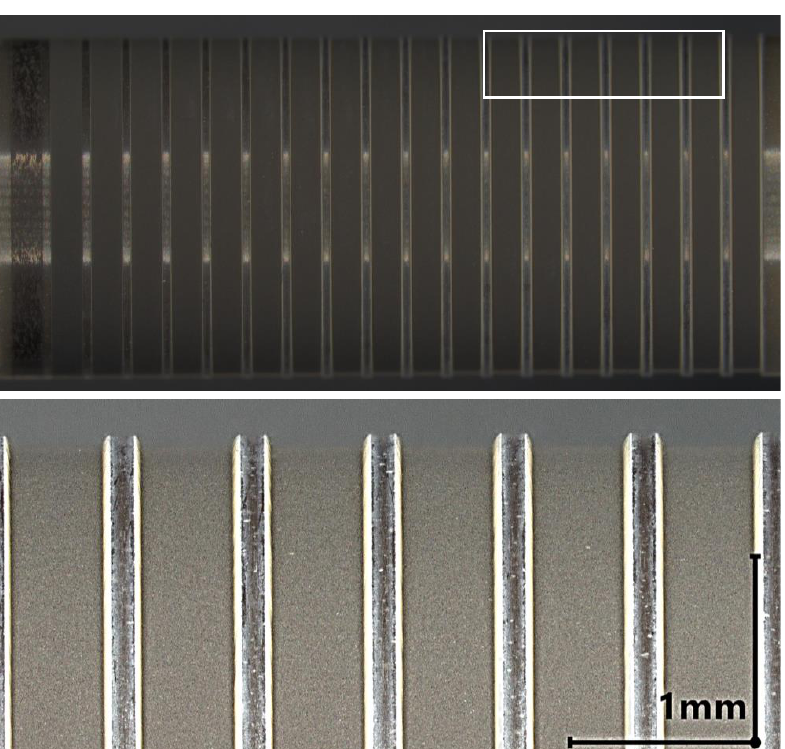
Figure 5. Top : Cylindrical SiAlON sample LKT 550 with a blank diameter of D = 6 mm after the laser ablation experiment at an angle of irradiation θ = 75°. At E p = 3 µ J (left) hardly any material removal can be detected but a change in surface is visible. Bottom : Detailed view of the groves machined with a pulse energy from E p = 15 µ J to E p = 20 µ J.